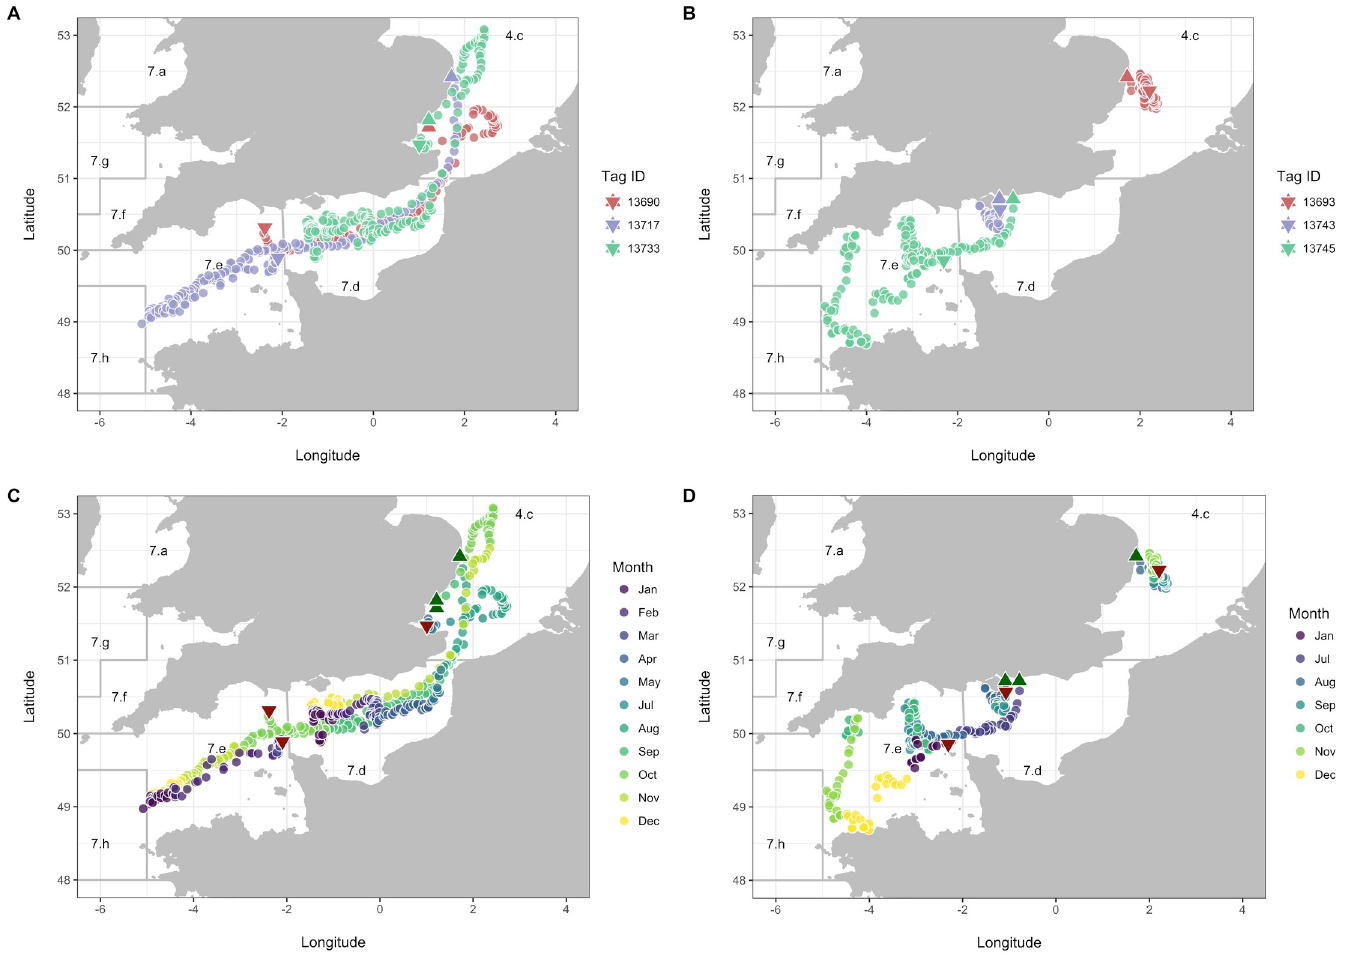
Fig 3. Movements of M . asterias tagged with electronic tags (n = 6). Daily locations in space and time have been coloured by Tag ID (A and B) and month (C and D; where data are recorded) to illustrate individual variation and seasonality, respectively. Individuals have been split based on movement pattern (migration, A and C; resident, B and D) for illustrative purposes. Release and recapture locations of M . asterias are plotted as triangles and inverted triangles, respectively. Each location represents an estimated geographical position per day (24